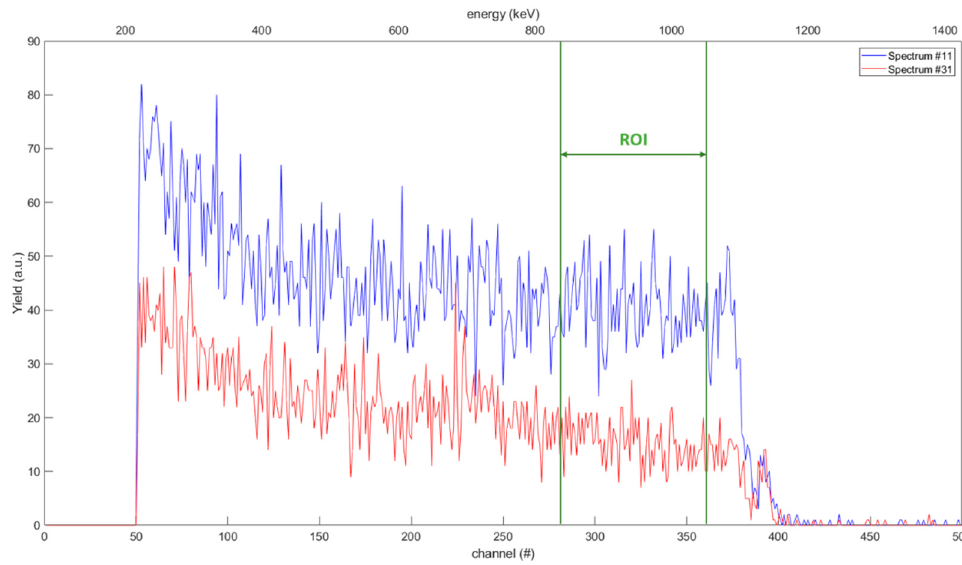
Table 2. Step #11 parameters.